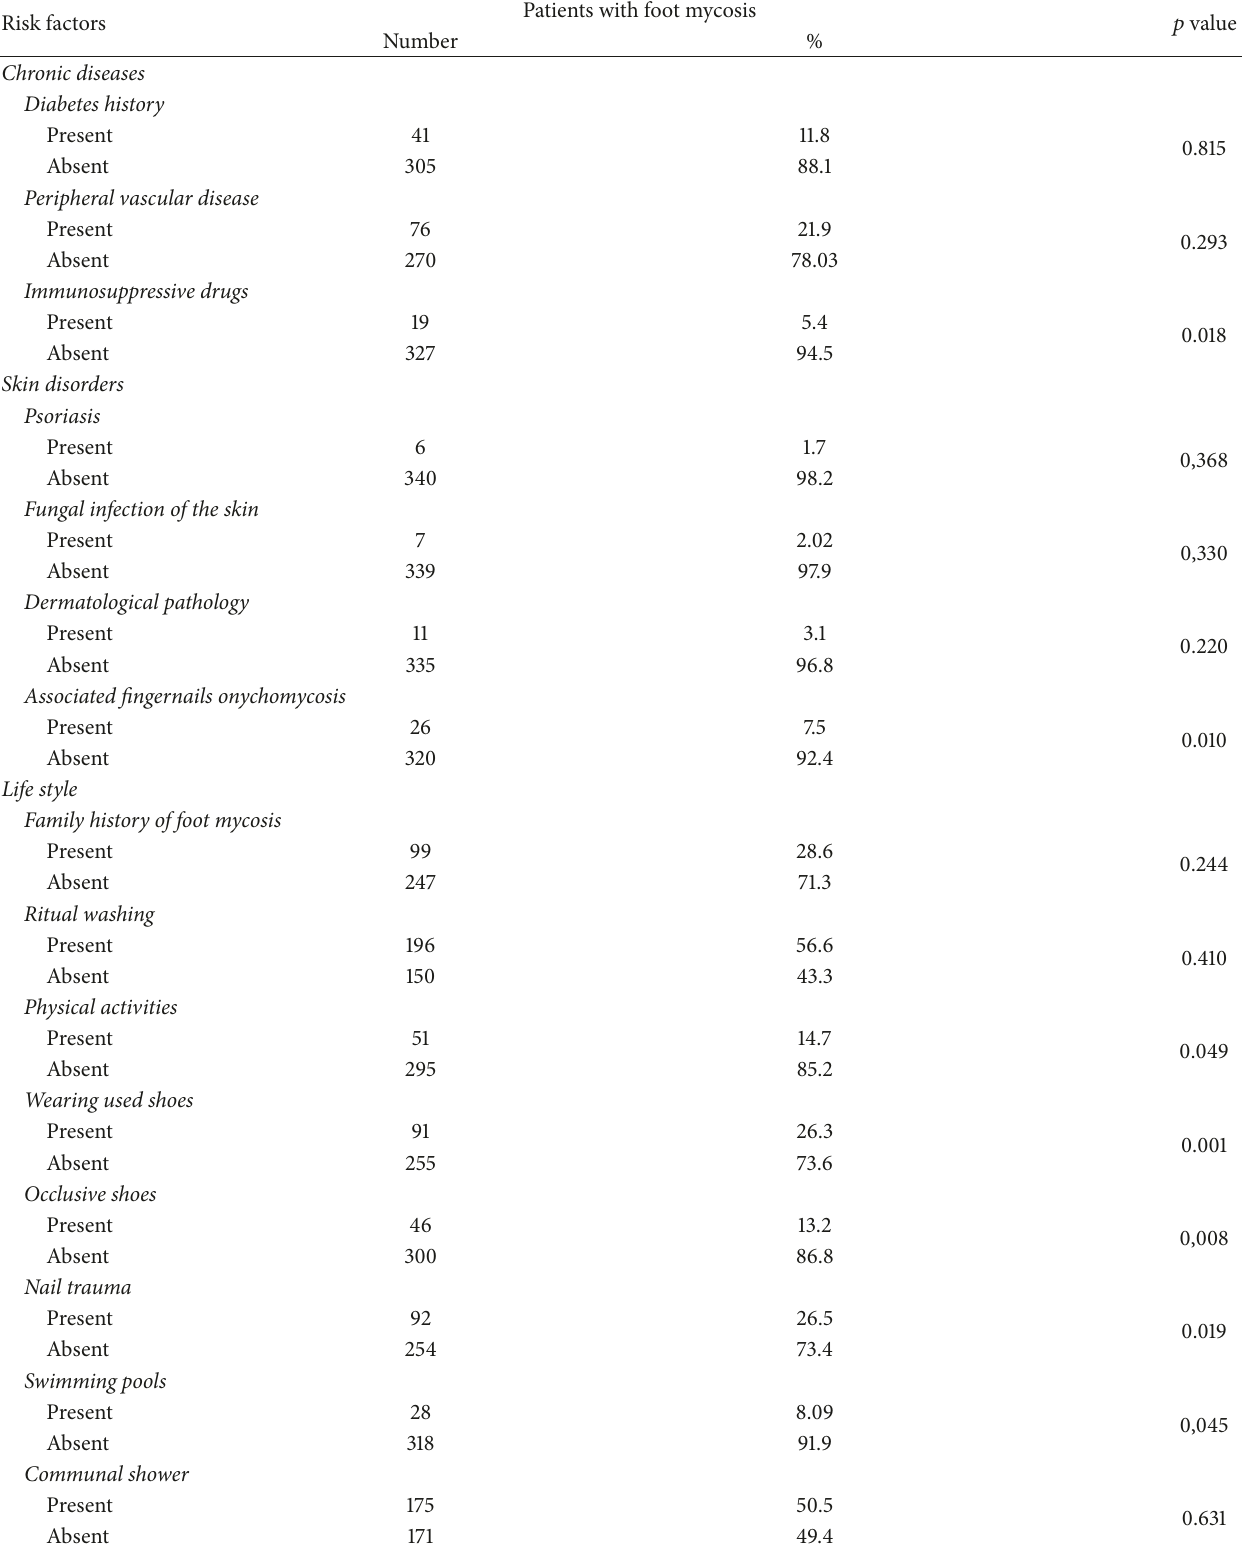
Table 5: Possible risk factors associated with foot mycosis based on the